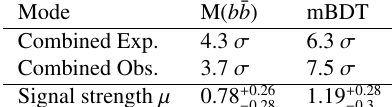
Table 3. Expected and observed significances, the best-fit signal strength modifier µ of the excess of events above the estimated background on the diboson production in b ¯ b final state.